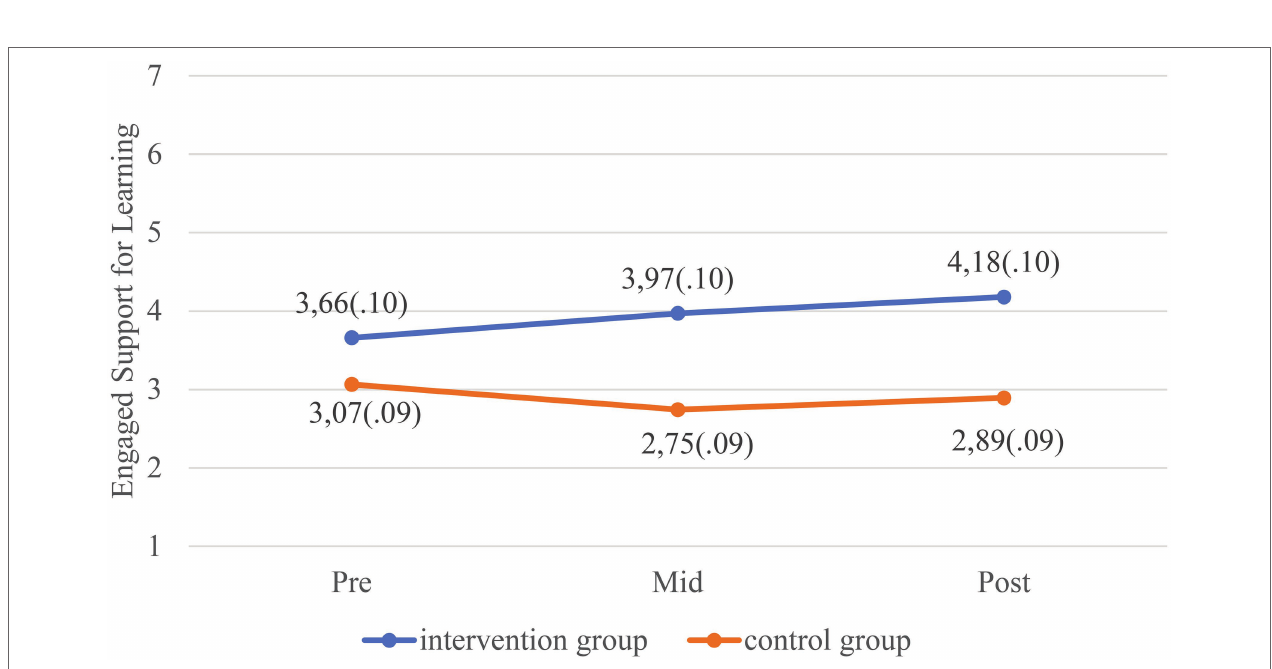
FIGURE 2 | Estimated marginal means with standard errors (SE) for Emotional and Behavioral Support (ESB) at three timepoints separated by groups. Higher scores indicate better quality.